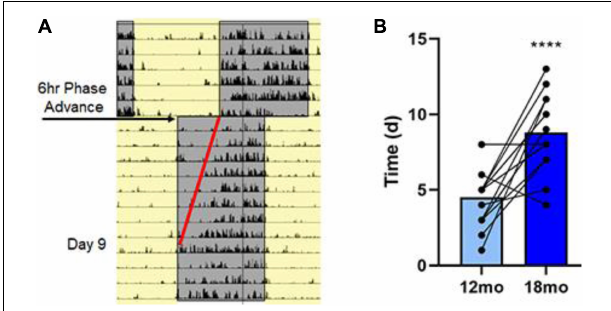
rat took 9 days to establish activity onset with lights off as highlighted by the red line. (B) Summary data for the time (in days) required to entrain to the 6 h phase advance for all the rats at 12 and 18 months. Average data and individual rat data for both ages demonstrating that there was an age-associated lengthening in the time to entrain for the 18-month rats. Asterisks indicated a significant ( p < 0.0001) difference from 12 month